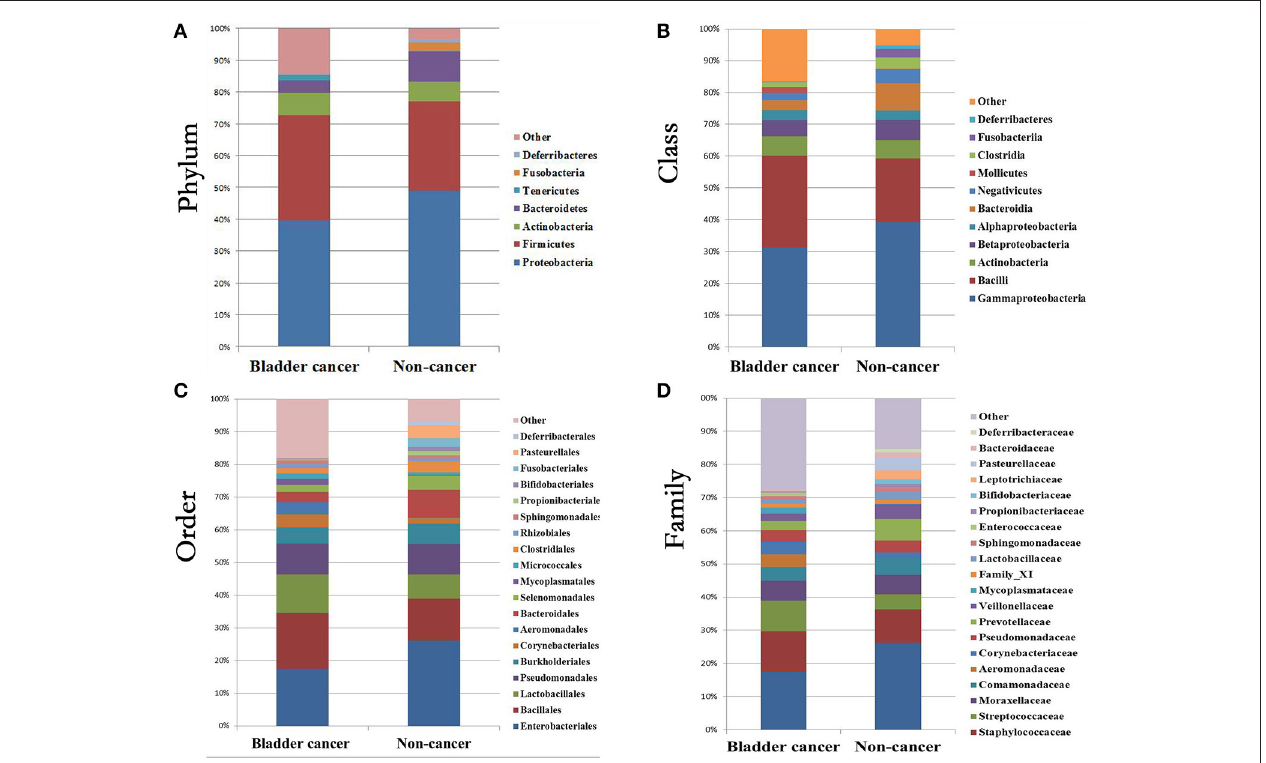
FIGURE 3 | Bacterial average relative abundance in bladder cancer and non-cancer samples. Average distribution of major taxa is represented by bar graphs. (A) phylum; (B) class; (C) order; (D) family. Each colored box represents a bacterial taxon and the height of a colored box represents the relative abundance of that organism within the sample. Bacterial genera with a relative abundance < 1% and unclassified genera are grouped as “Other”.